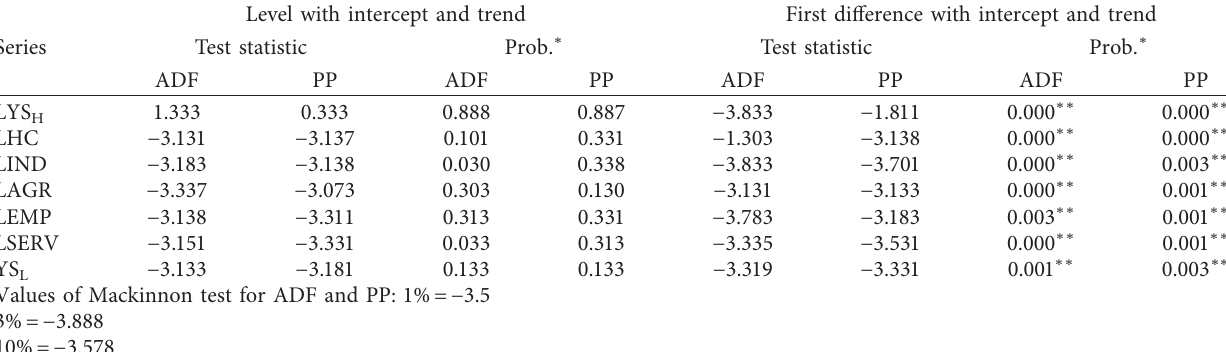
Table 1: Results of ADF and PP unit root tests at level and at first